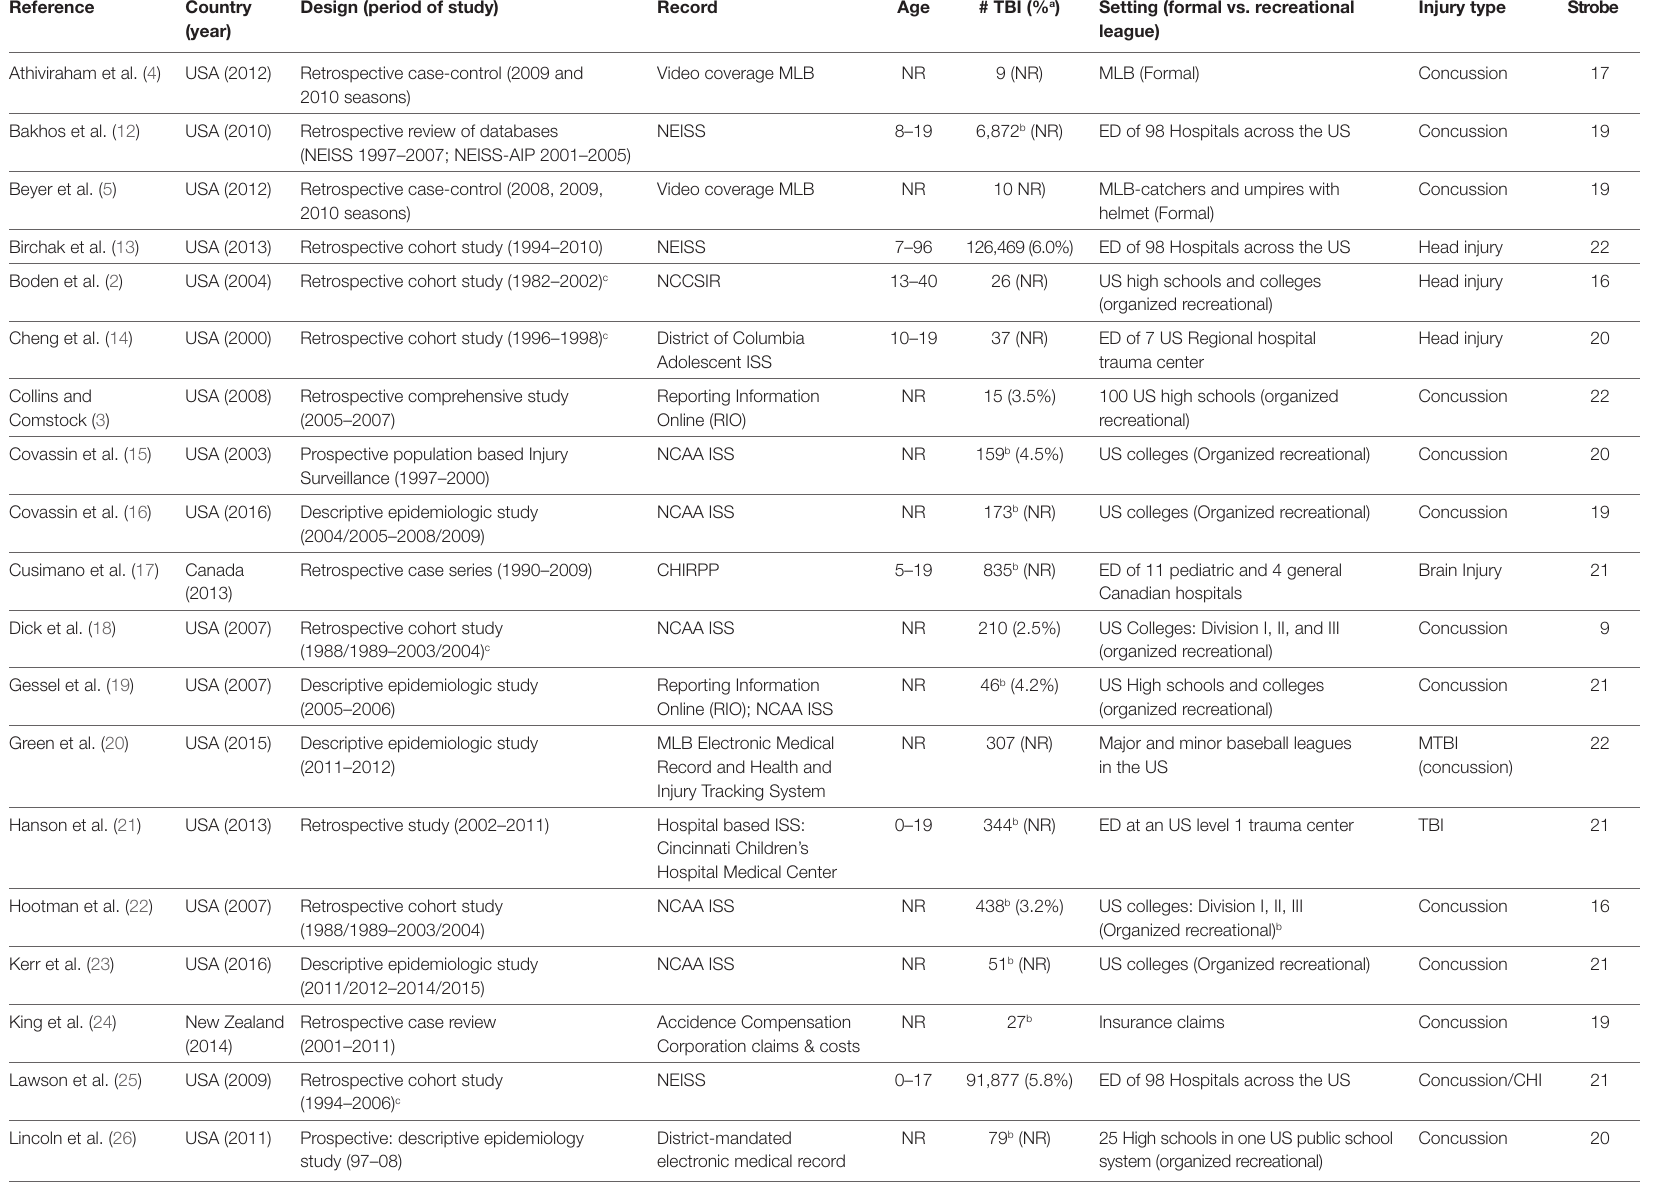
taBLe 2 | Characteristics of included